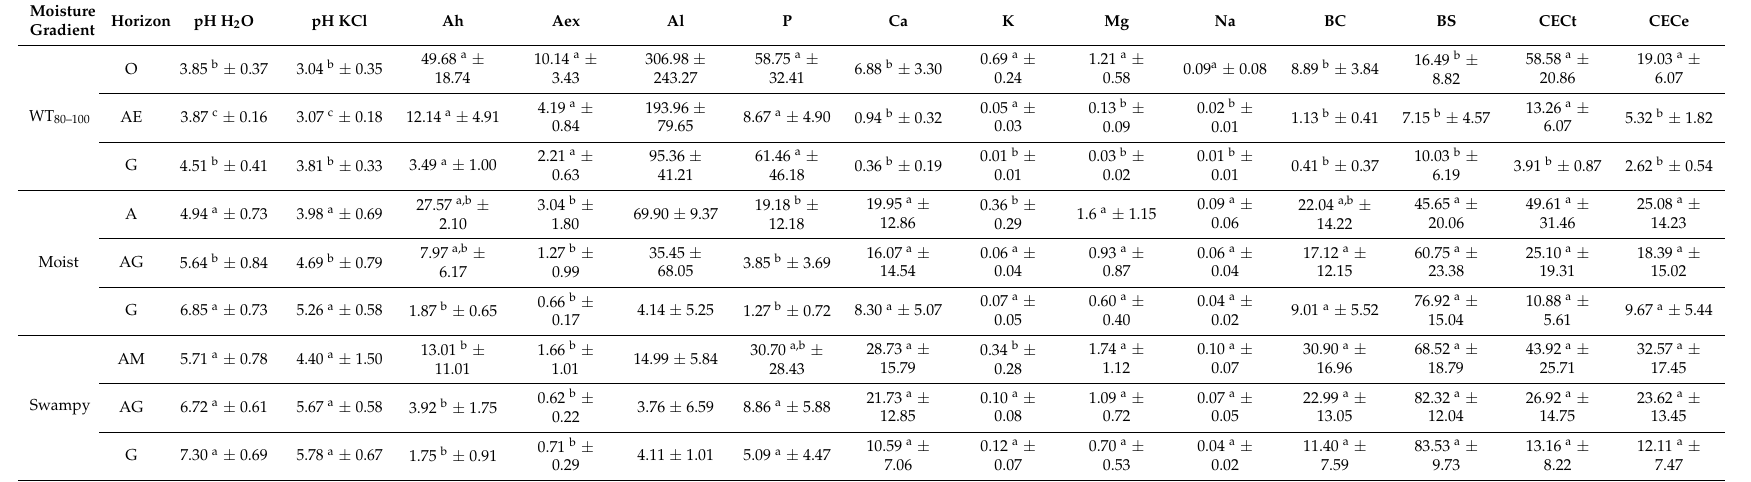
Table 2. Chemical properties of study